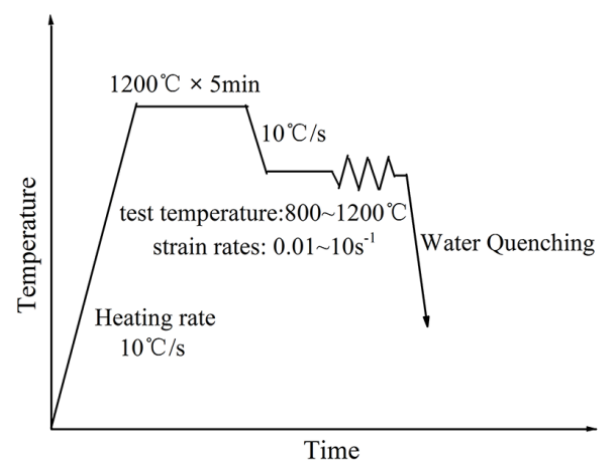
Figure 1. A schematic representation of hot compression process.